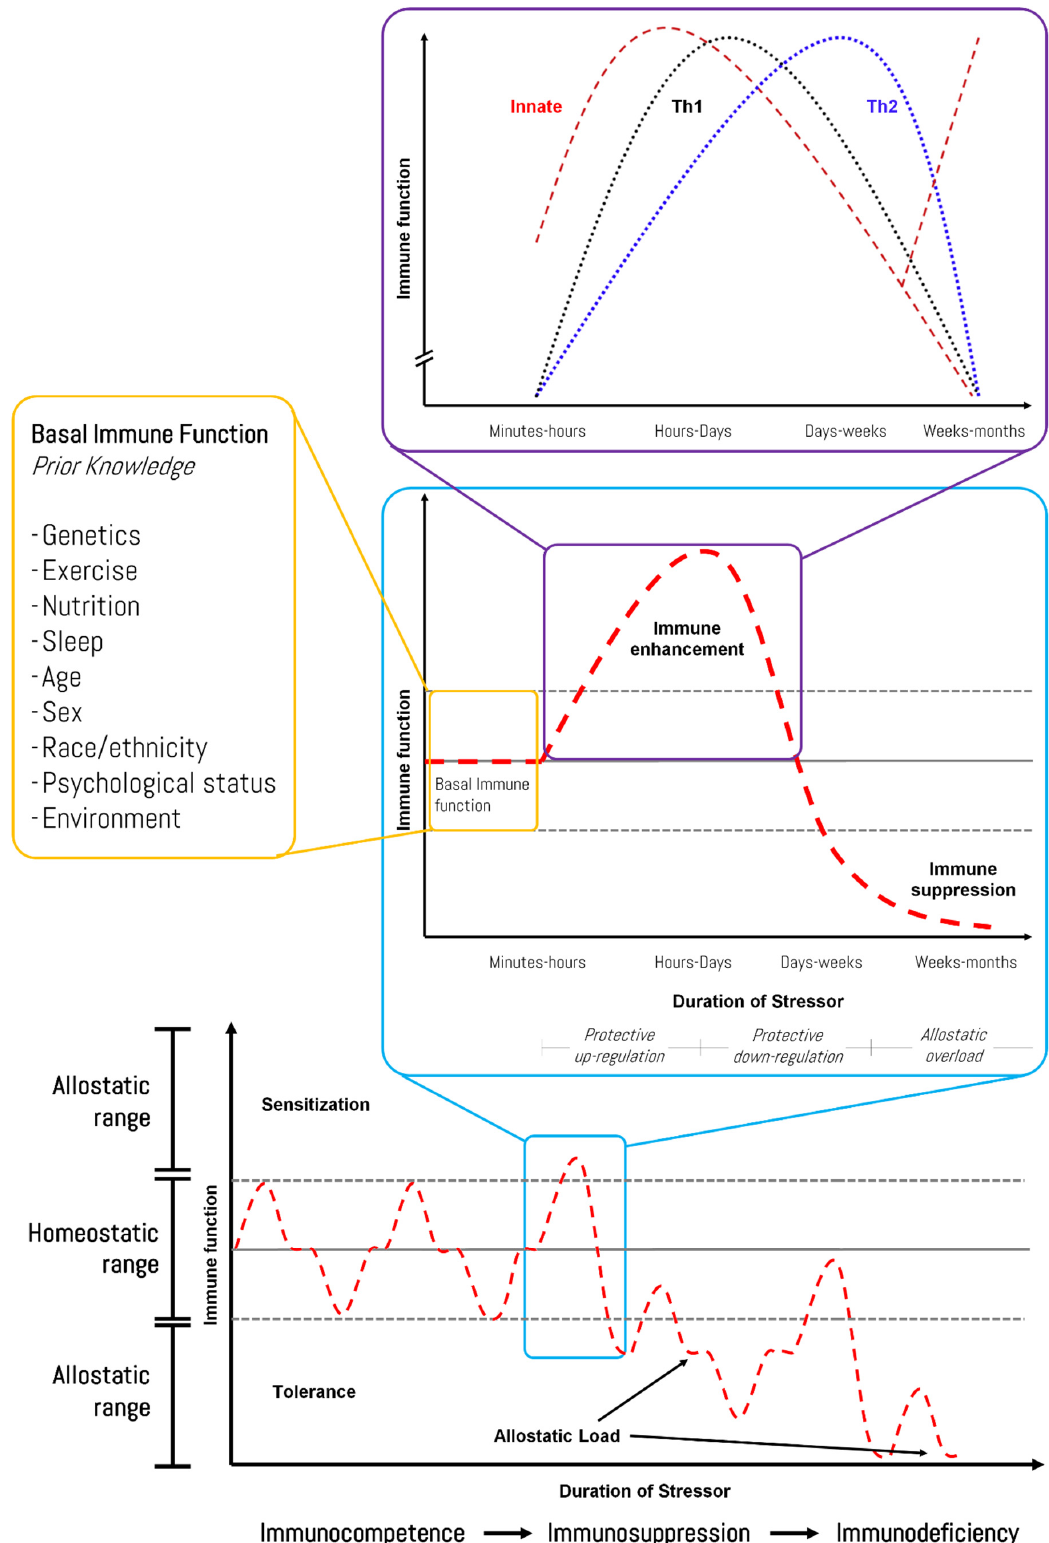
Figure 1. Representation of the changes in the immune function in response to stress. The figure shows the response pattern of immune activity to distinguish between allostatic load in the normal life cycle and allostatic overload that exceeds the capacity of the biological system to cope. See the previous paragraphs of the manuscript for further rationale. Source: designed by the authors (D.A.B.) based on published materials